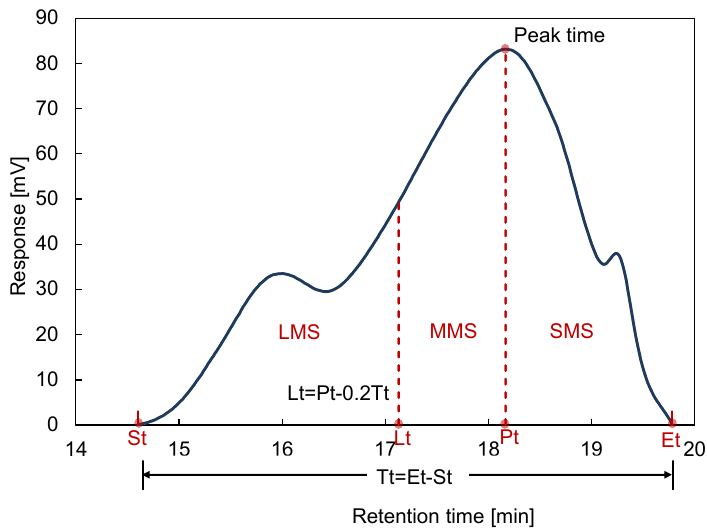
Figure 3. Illustration of determining LMS time (Lt) from total retention time (Tt) of the chromatogram of virgin binder (asphalt A), based on ending time (Et) and starting time (St) [22].